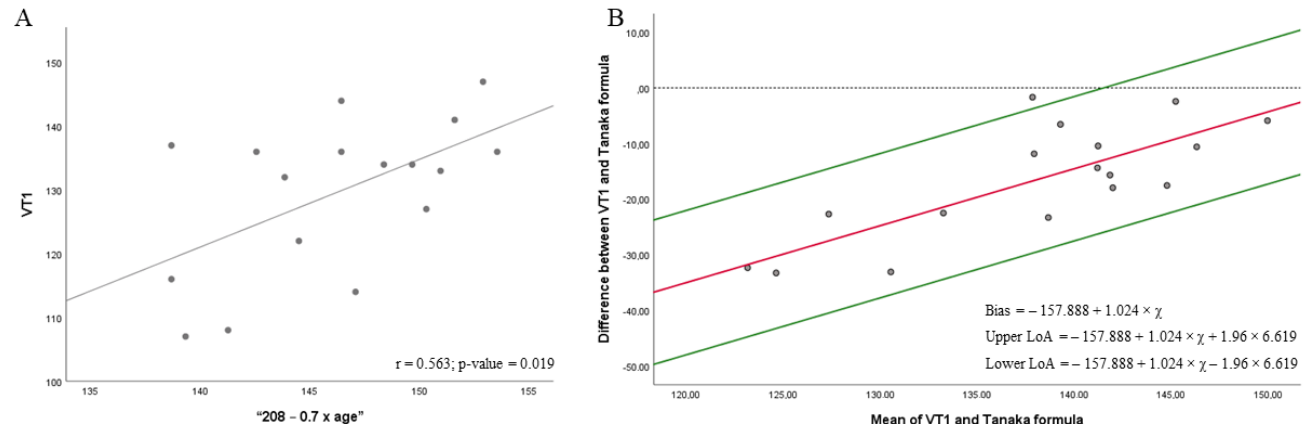
Figure 2. Correlations ( A ) and Bland–Altman plots ( B ) between the heart rate achieved in the VT1 in the cardiopulmonary exercise testing (CPET) and the mathematical model to predict the maximum heart rate “208 − 0.7 × age” at 76%.